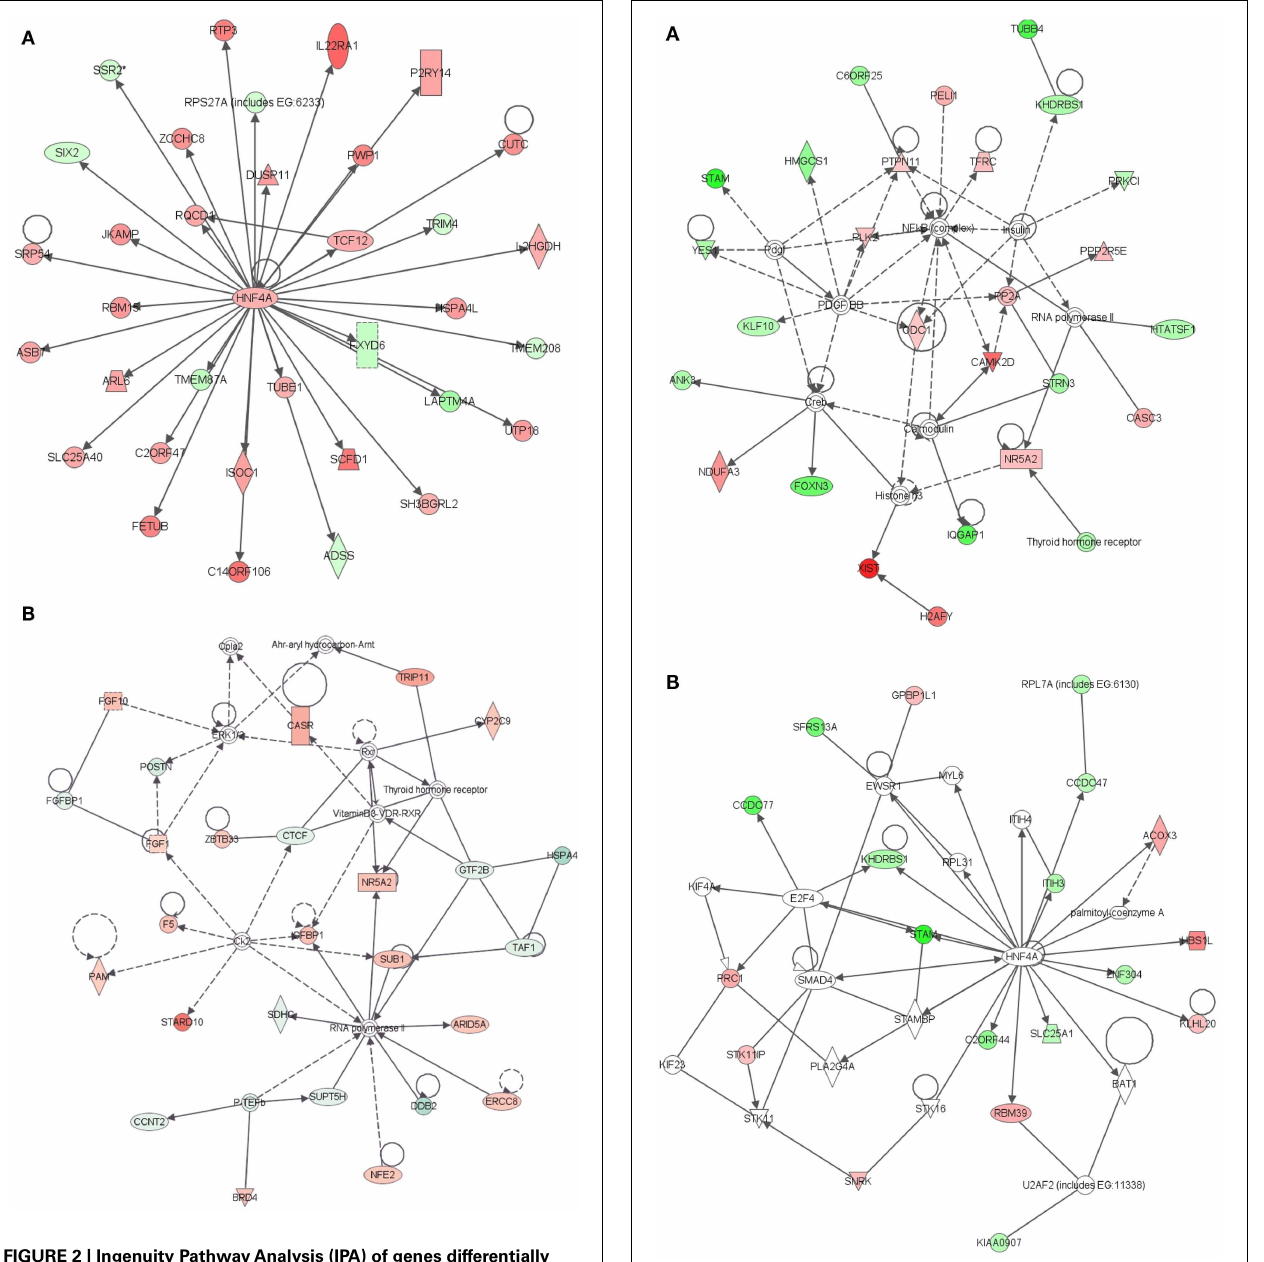
and the overall epithelial population appear to be similar and not likely to unduly influence interpretation of gene expression